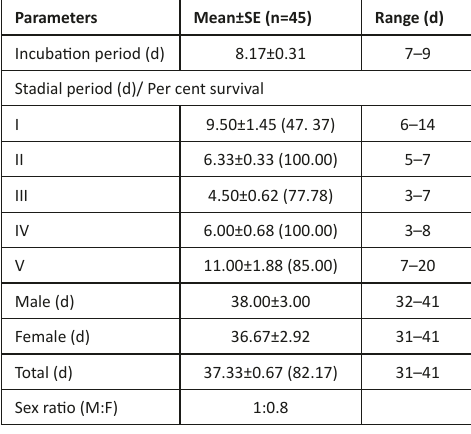
Table 2. Incubation and developmental period of C. gilvus